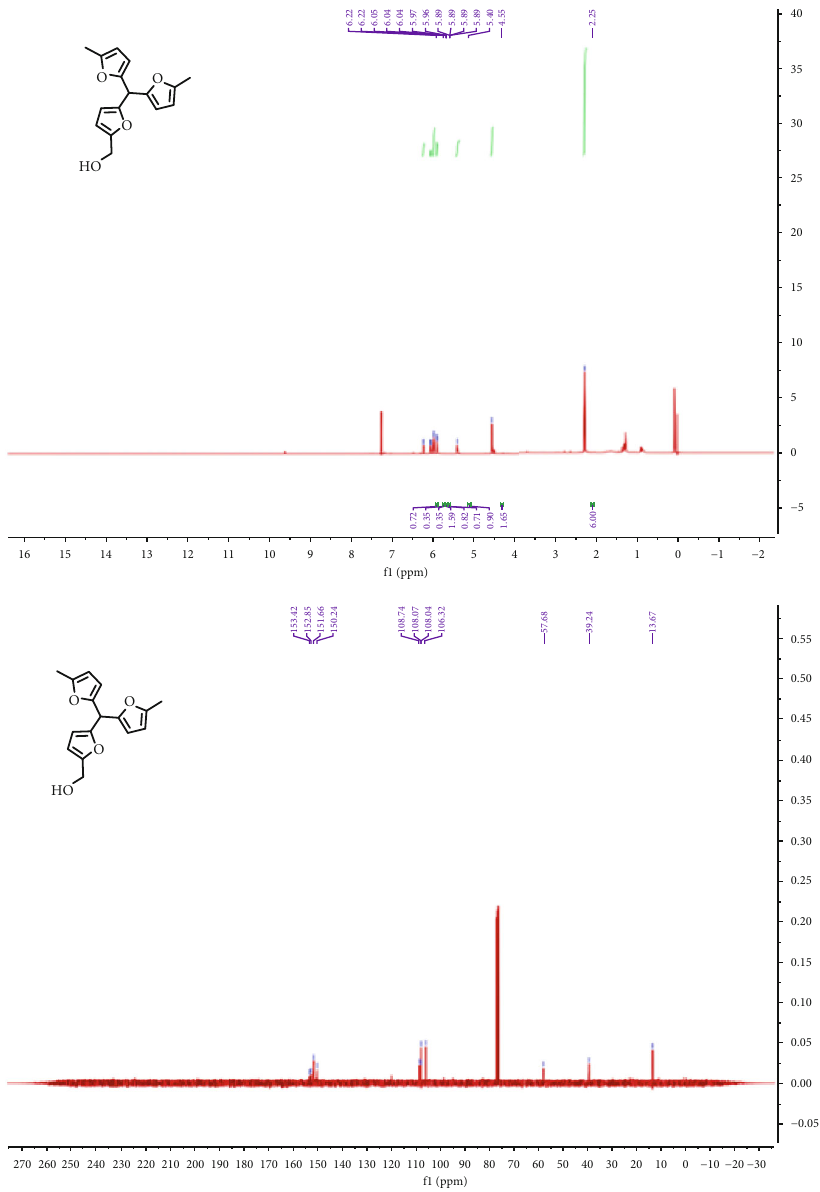
Figure 10: 1 H and 13 C NMR spectra of intermediate 1. Intermediate 1: 1 H NMR (500MHz, CDCl 6.04 ( d , J = 0 : 7 Hz, 1H), 5.97 ( d , J = 3 : 1 Hz, 2H), 5.89 ( d , J = 1 : 0 Hz, 1H), 5.89 ( d , J = 1 : 0 Hz, 1H), 5.40 (s, 1H), 4.55 (s, 2H), 2.25 (s, 6H). 13 C ) δ = 153 : 42 , 152.85, 151.66, 150.24, 108.74, 108.05, 106.32, 57.68, 39.24, NMR (126MHz, CDCl 3